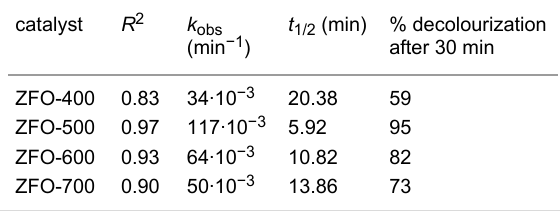
Table 1: First-order fitting results of Congo red decolourization over ZFO samples.